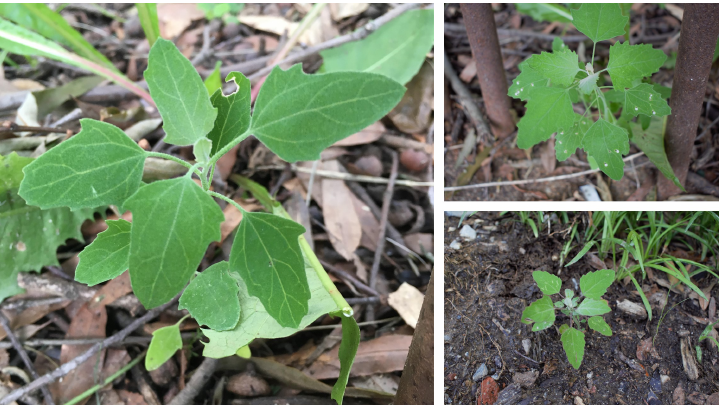
Figure 2. Young lambsquarters found around the UDC campus. Courtesy of Brianna